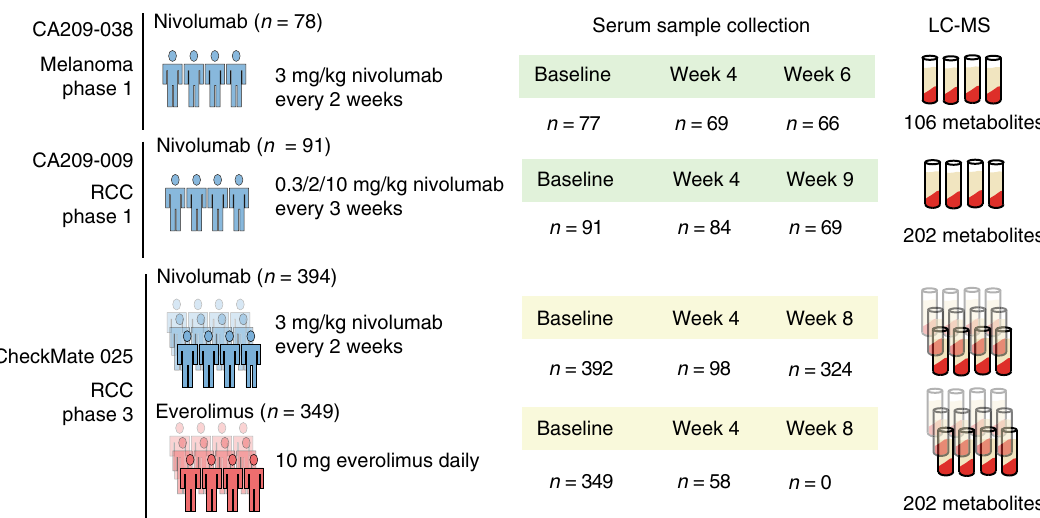
Fig. 1 Schematic of study design and serum specimen collection. This study consisted of serum specimens from two phase 1 trials and one randomized phase 3 trial. The cancer and treatment type/dosing, number of serum samples collected at each time point, and number of metabolites identi fi ed by LC- MS are labeled as above. 63 overlapping metabolites were pro fi led in all three